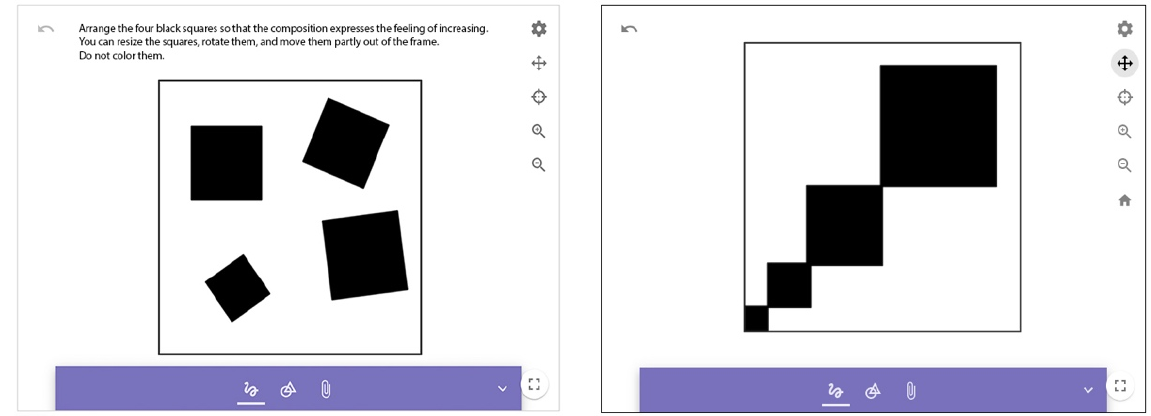
Figure 5. Geometric shapes.